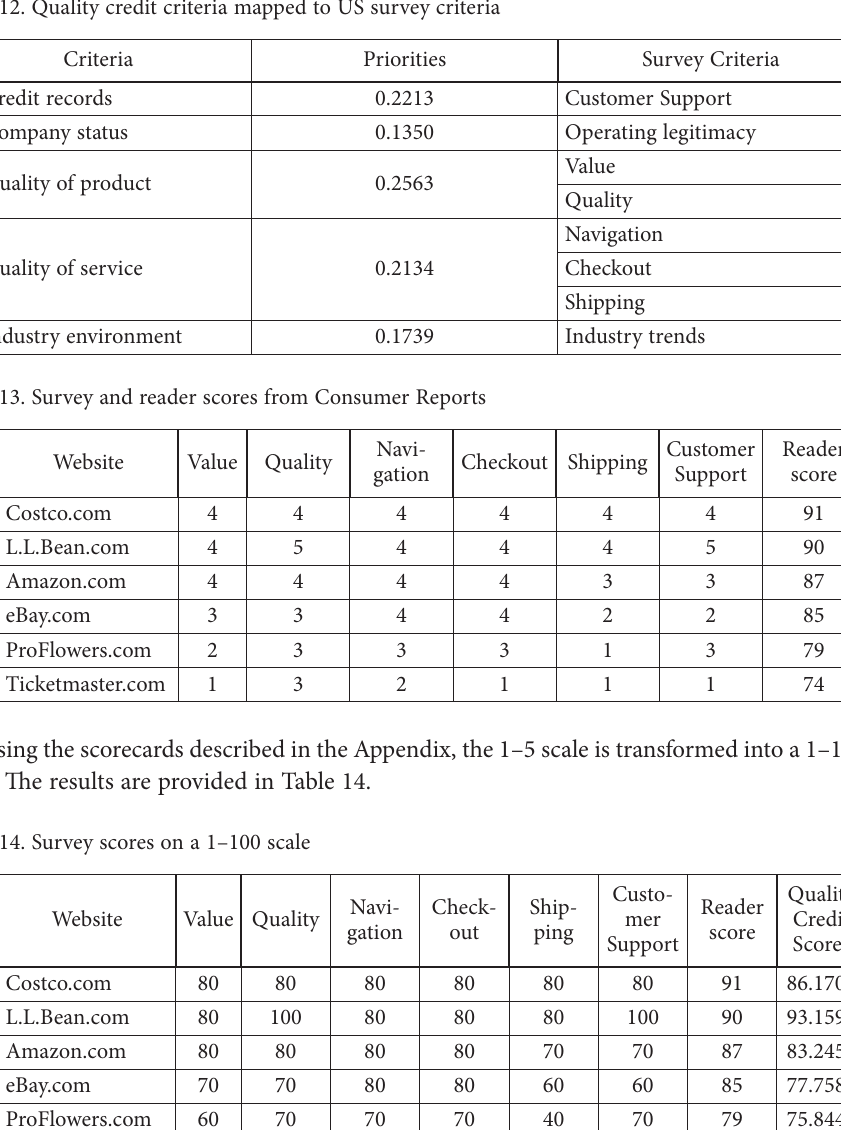
Table 12. Quality credit criteria mapped to US survey criteria Criteria